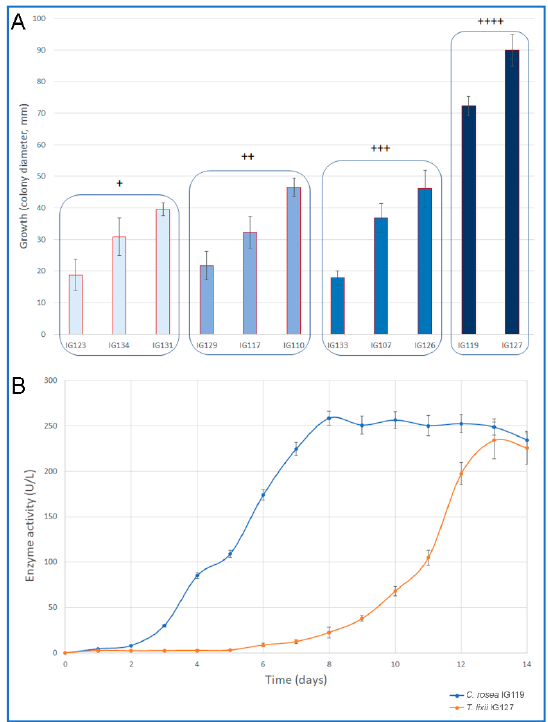
Figure 1. ( A ) growth of marine fungal isolates on the media used for the detection of chitinolytic activity. The isolates have been grouped on the base of their enzyme activity (scores from “+” to “+++”. ( B ) Time course of chitinolytic enzyme production of Trichoderma lixii IG127 and Clonostachys rosea IG119 on the medium used for the secondary screening.